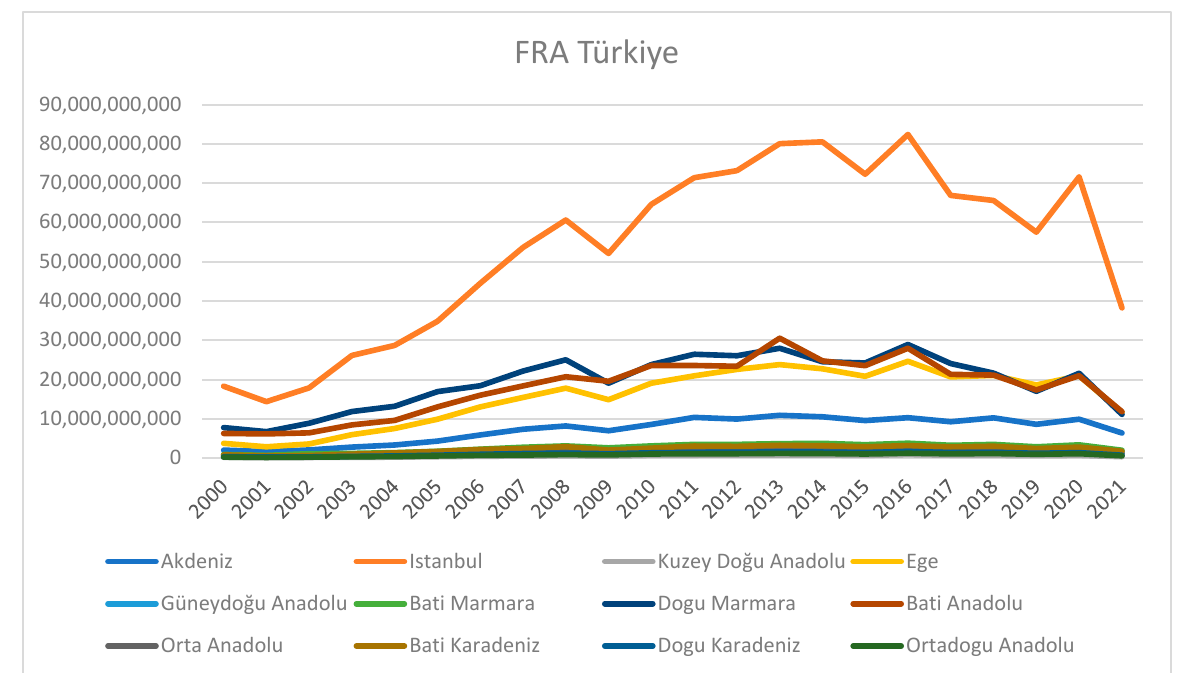
Figure 3. FRA Turkey (USD). Source: Turk Statistical Institute.